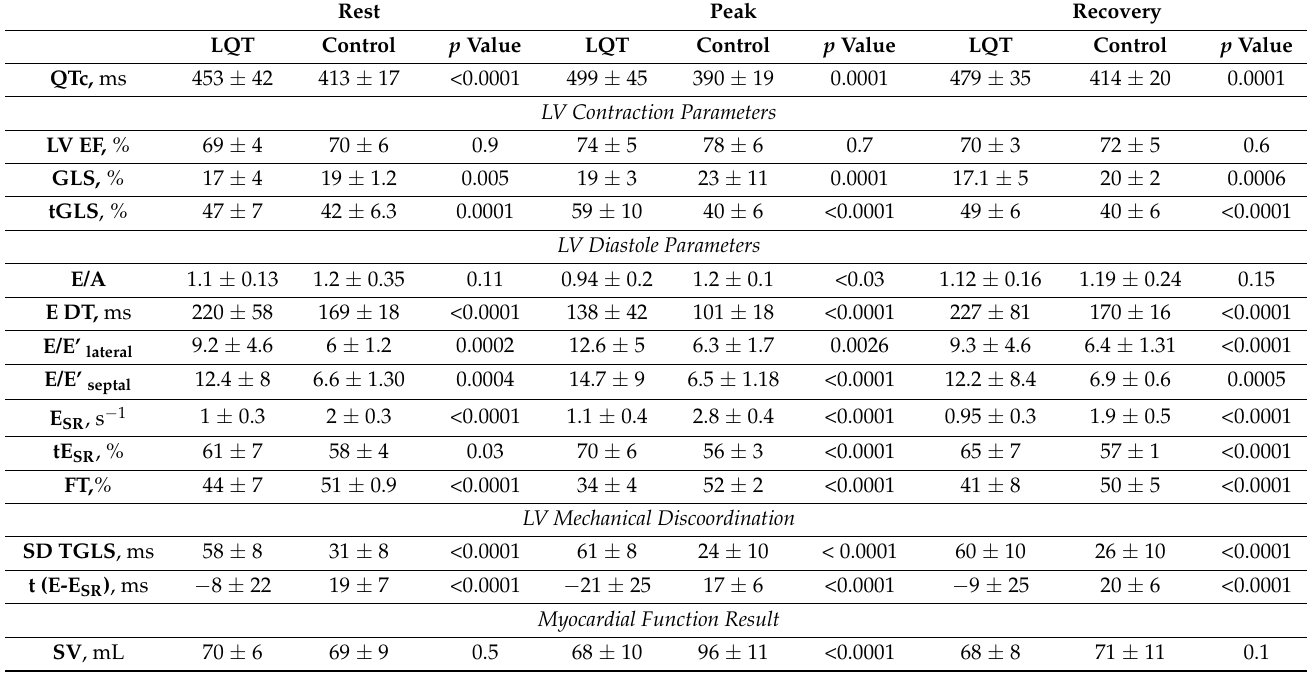
Table 1. Left ventricular function at rest, peak exercise, and four minutes into recovery in